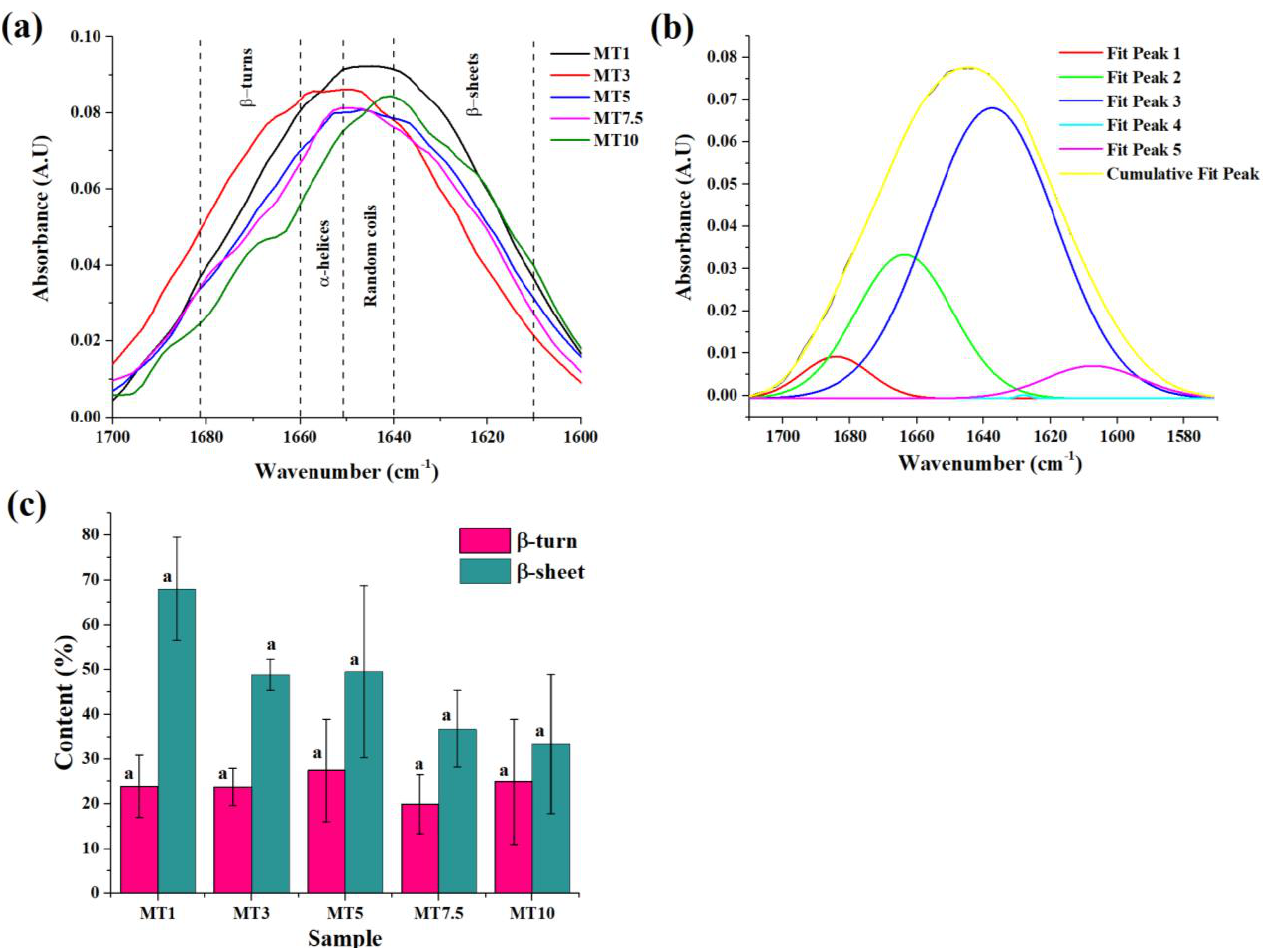
Figure 7. Graphs showing ( a ) Amide I region containing different protein secondary structures in different samples, ( b ) a representative graph of the deconvoluted Amide I region, and ( c ) variation of different structures obtained in the Amide I region with respect to different samples. The alphabets above columns of the same color denote statistically significant ( p < 0.05) differences.